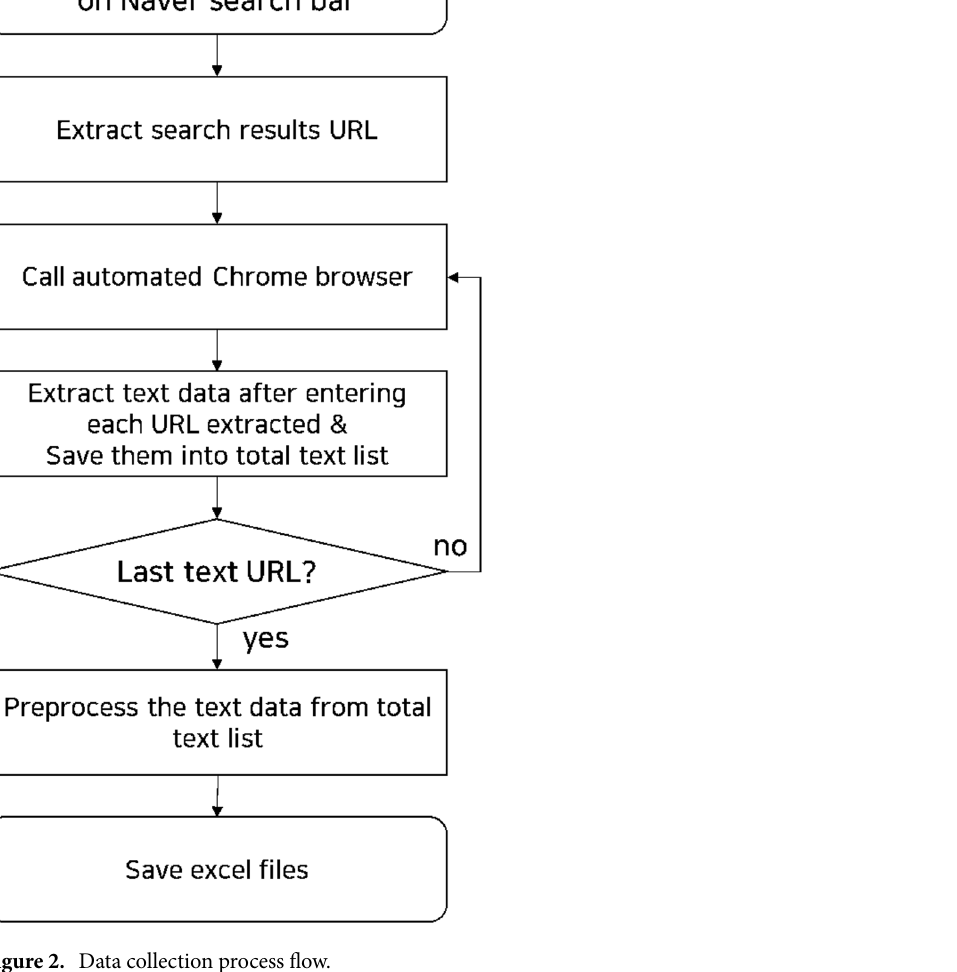
Figure 2. Data collection process